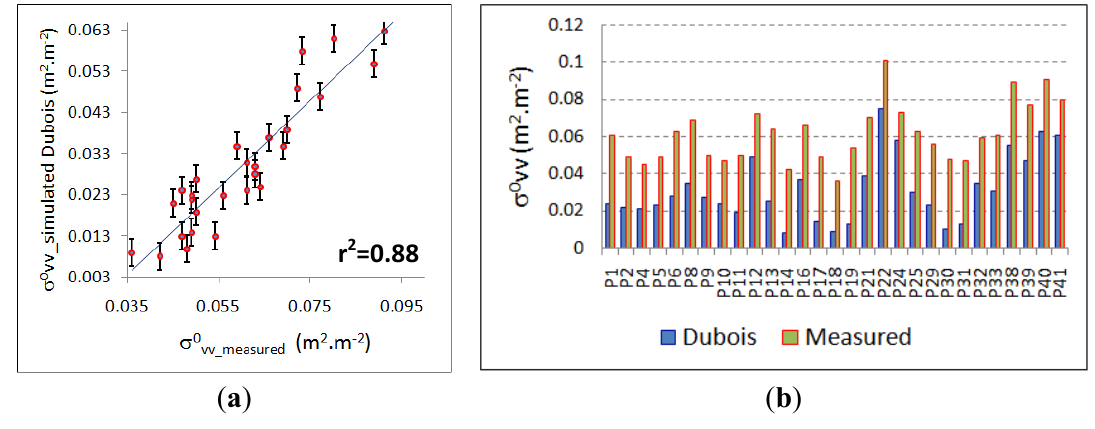
σ vs. measured- 0 σ regression analysis, ( b ) Dubois- 0 Figure 13. ( a ) Dubois- 0 vv vv σ values. (Error bars show the standard error value). vs. measured- 0 vv